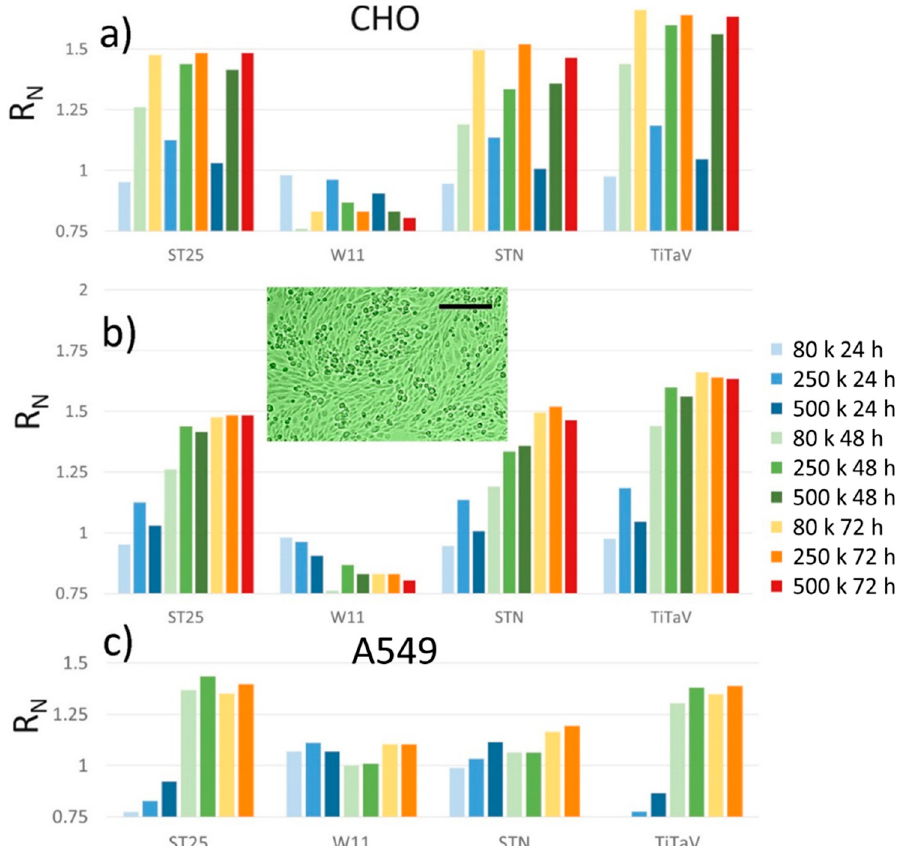
Figure 12. Sensor responses to CHO and A549 cell lines. Cells plated at 80 K (lightest colors), 250 K (light colors), 500 K (medium dark colors), and 1 M (darkest colors) cells/dish, measured after being withdrawn from the incubator at 24 h (blue), 48 h (green) and 72 h (orange); ( a ) CHO cells sorted for the same concentration at different times of incubation; ( b ) CHO cells sorted for the same time of incubation but at different concentrations; the TiTaV response to A549 plated at 80 K cells/dish is not visible because it was smaller than 0.75; ( c ) A549 cells, same color coding as ( b ). Insert, microphotograph of CHO cells seeded at 500 K cells/dish after 48 h of plating; scale bar is 200 µm.